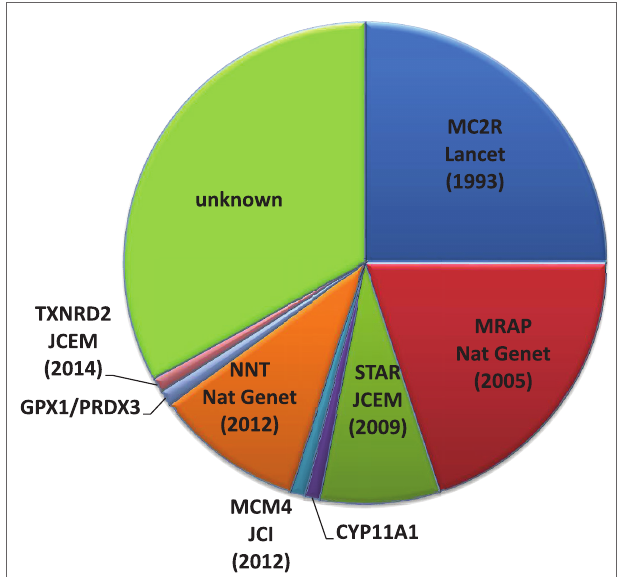
FigUre 1 | Pie chart indicating the percentage of FgD cases due to gene mutations in the Melanocortin 2 receptor ( MC2R ), Mc2r accessory protein ( MRAP ), Mini chromosome maintenance deficient 4 ( MCM4 ), nicotinamide nucleotide transhydrogenase ( NNT ), steroidogenic acute regulatory protein (sTar), cytochrome p450 11a1 (cYP11a1), Thioredoxin reductase 2 ( TXNRD2 ), glutathione peroxidase 1 ( GPX1 ), and Peroxiredoxin 3 ( PRDX3 ) in our patient cohort